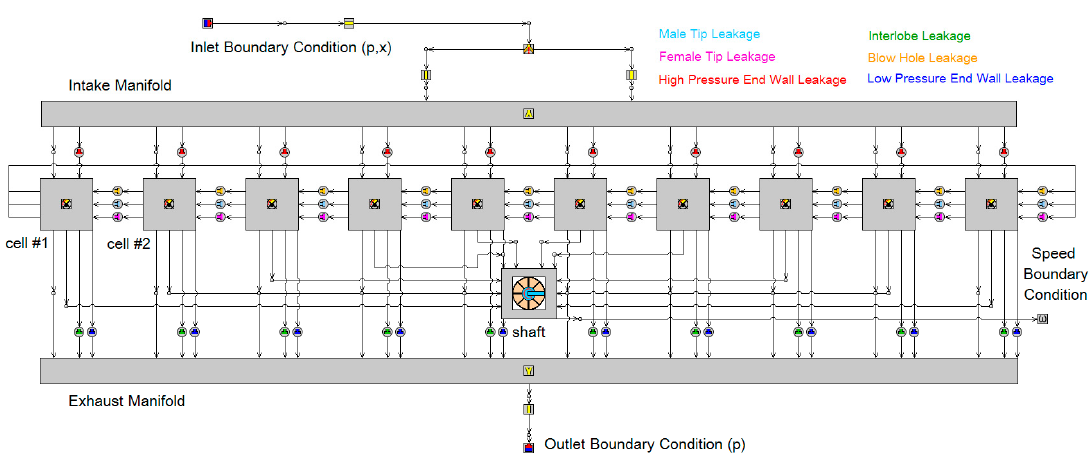
Figure 8. Twin-screw expander model block diagram (data refer to Table 1).